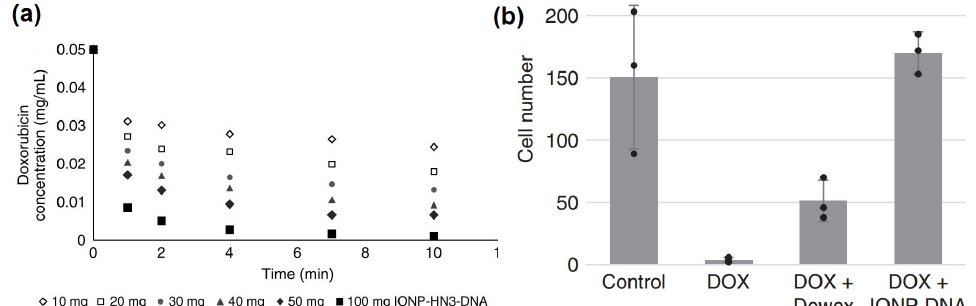
Figure 8. ( a ) DOX concentration in the presence of various amounts of DNA-conjugated IONPs and ( b ) rescue of cultured cells from DOX toxicity by DNA-conjugated IONPs. Adapted with permission from reference [35].